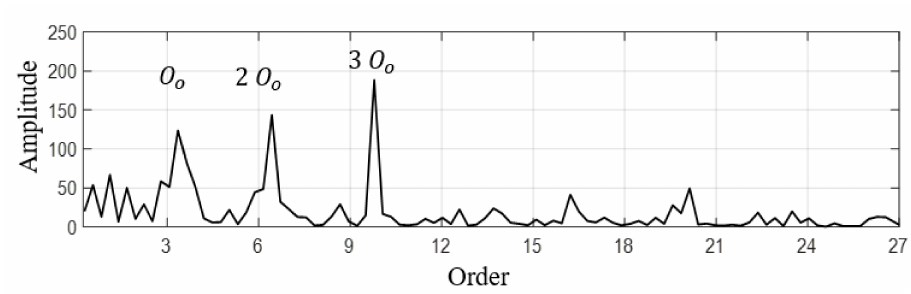
Figure 8. Envelop order spectrum of the faulty bearing